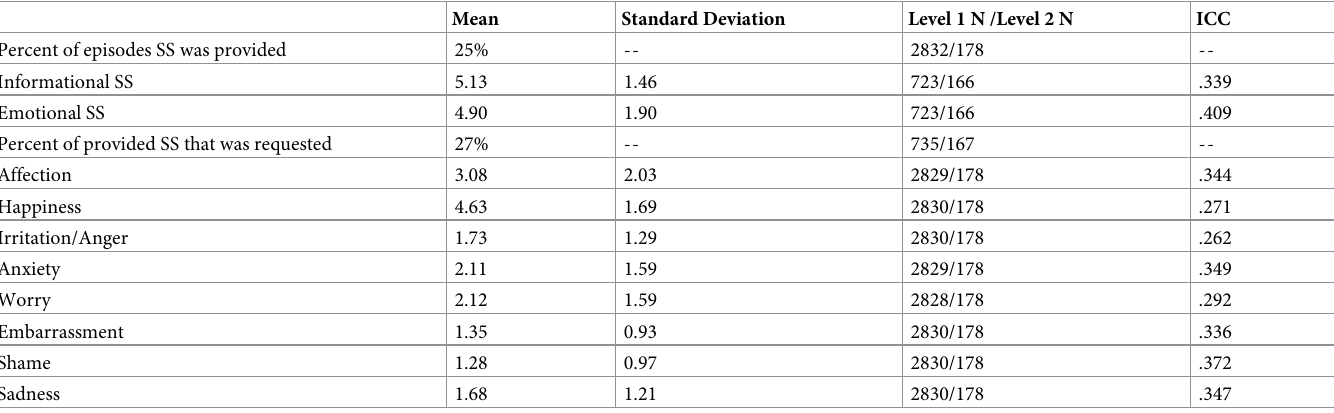
Table 1. Means and standard deviations of SS characteristics and